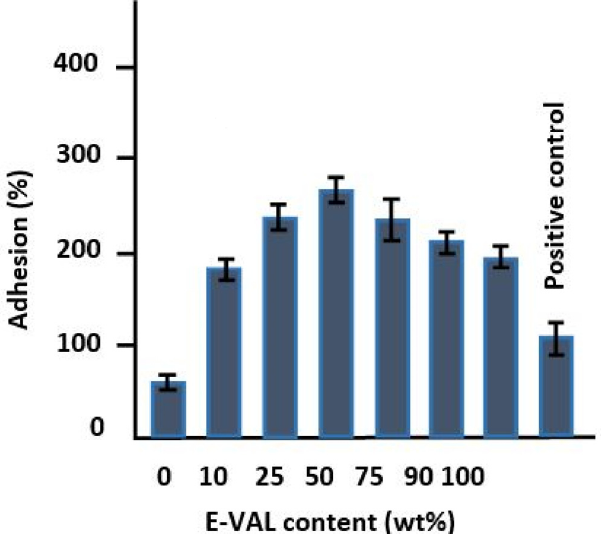
Figure 9. Cell adhesion tests on the prepared pure PCL, E-VAL and E-VAL / PCL materials with di ff erent E-VAL contents.